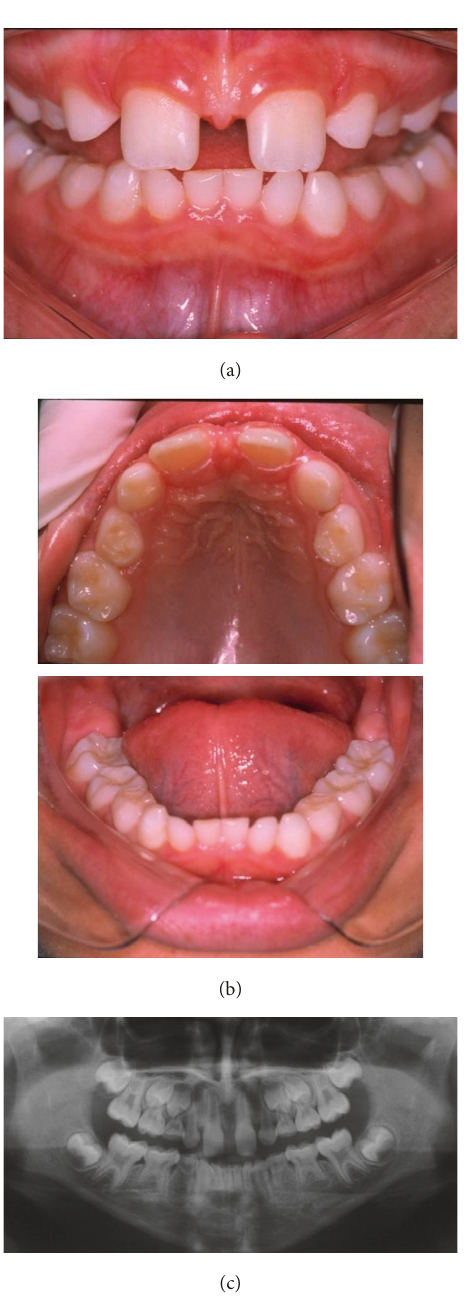
Figure 2: Patient 1. Accentuated diastema between the upper central incisors due to insertion of the labial frenulum (a), mixed dentition with no caries (b), and absence of the 31, 41, 12, 22, 32, 42, 13, 23, 33, 43, 34, 44, 35, and 45 teeth (c).